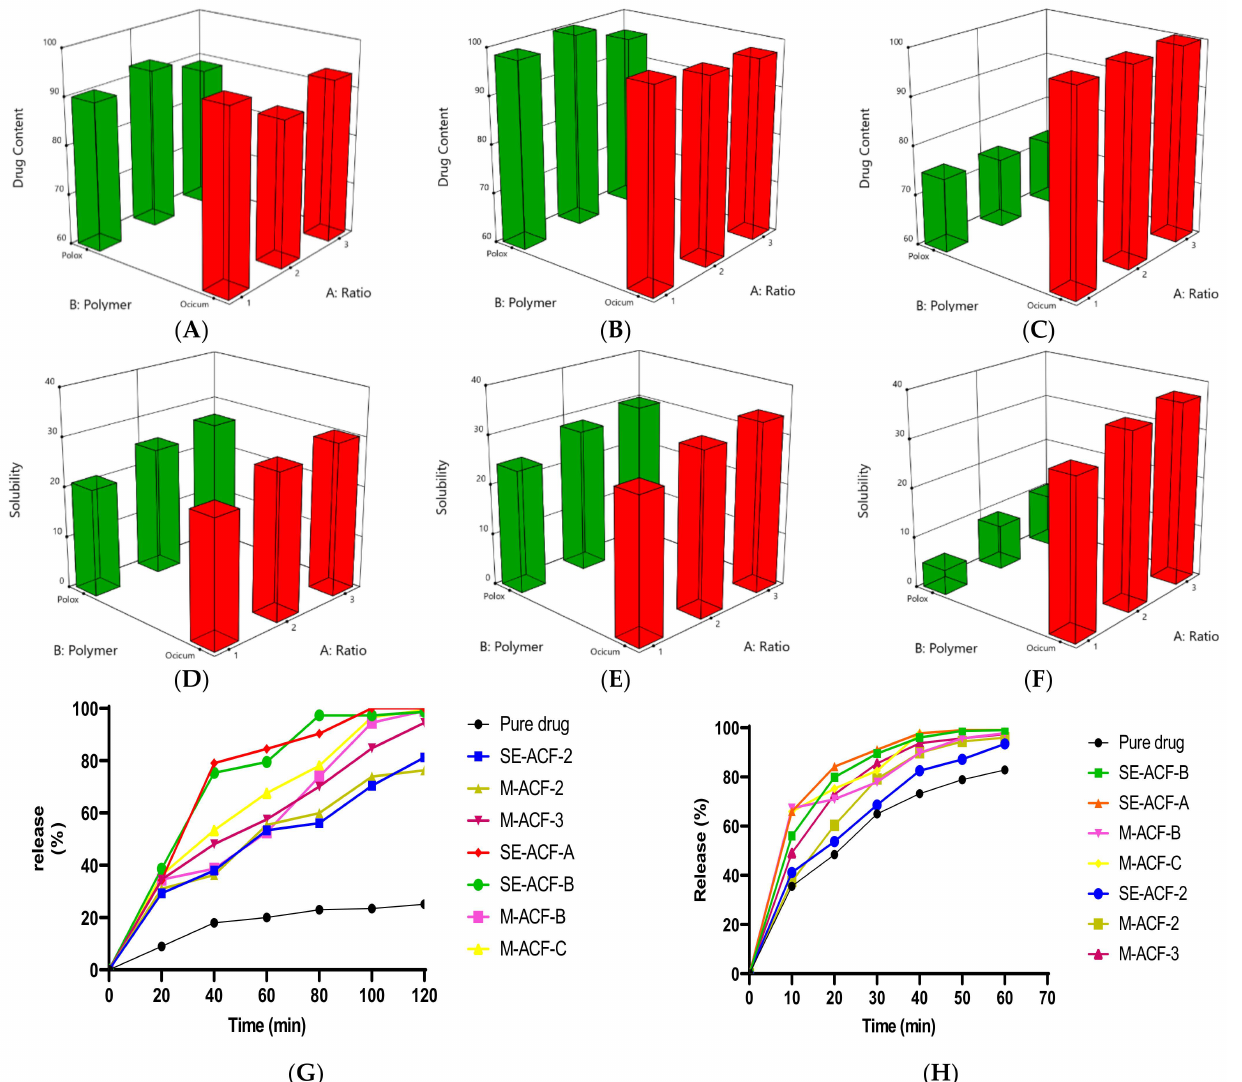
Figure 6. Three-dimensional plots of combined effects of polymer, their ratios and methods of preparation of solid dispersion on the aceclofenac content prepared using different methods ( A – C ); combined effects of polymer, their ratios and preparation methods on the aceclofenac solubility form solid dispersions prepared using different methods ( D – F ); dissolution of aceclofenac in Ocicum- and Poloxamer 407-based solid dispersions in ( G ) aqueous media and ( H ) phosphate